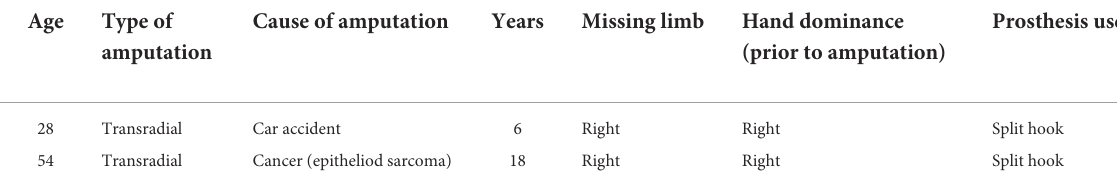
TABLE 1 Medical records of amputee subjects.